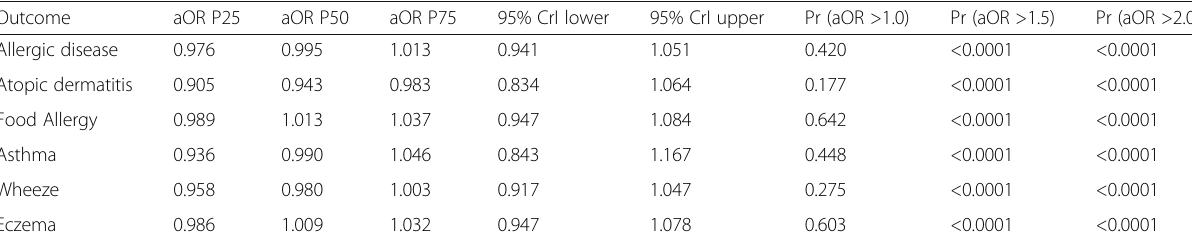
Table 2 Results of Bayesian multivariable logistic regression for allergic symptoms using vaccine types and covariates for complete cases (RQ1)